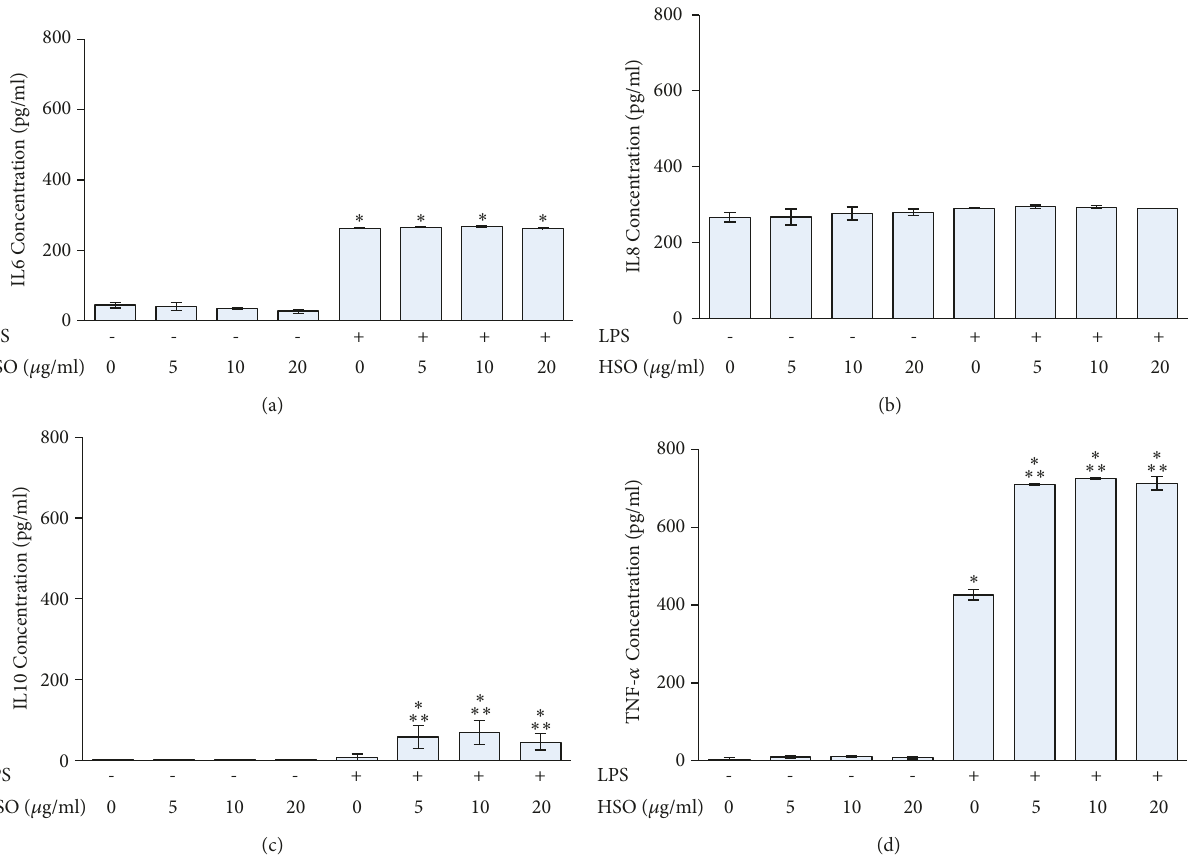
Figure2:TheeffectofHSOonIL6(a),IL8(b),IL10(c),andTNF- 𝛼 (d)productioninPBMCsandLPS-treatedPBMCs.PBMCswereseparated using Ficoll-Paque density centrifugation, seeded in 12-well plates, and treated with 10 𝜇 g/ml LPS and HSO at the indicated concentration for 24 h. Levels of IL6, IL8, IL10, and TNF- 𝛼 secretion were determined using ELISA with specific antibodies to each cytokine. ∗ p < 0.05 compared to control group; ∗∗ p < 0.05 compared to LPS-treated group